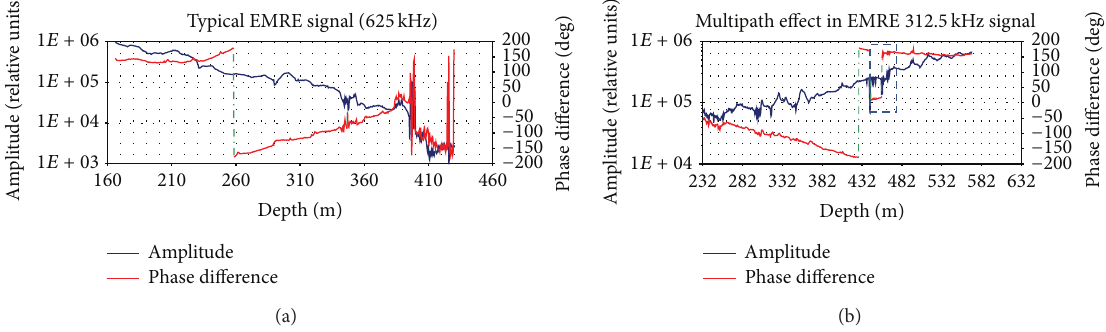
Figure 6: (a) A possible multipath effect (Rayleigh scattering) at 442–457 m. The phase has suddenly changed by ∼ 130 degrees, meaning a longer path of ∼2/5 ⋅ 𝜆 for the multipath wave. The change in the phase at ∼ 427 m is due to the presentation mode ( − 180 ∘ to +180 ∘ ). Due to the presentation mode, the phase is plotted between − 180 ∘ and +180 ∘ . (b) Recording in a massive sulphide